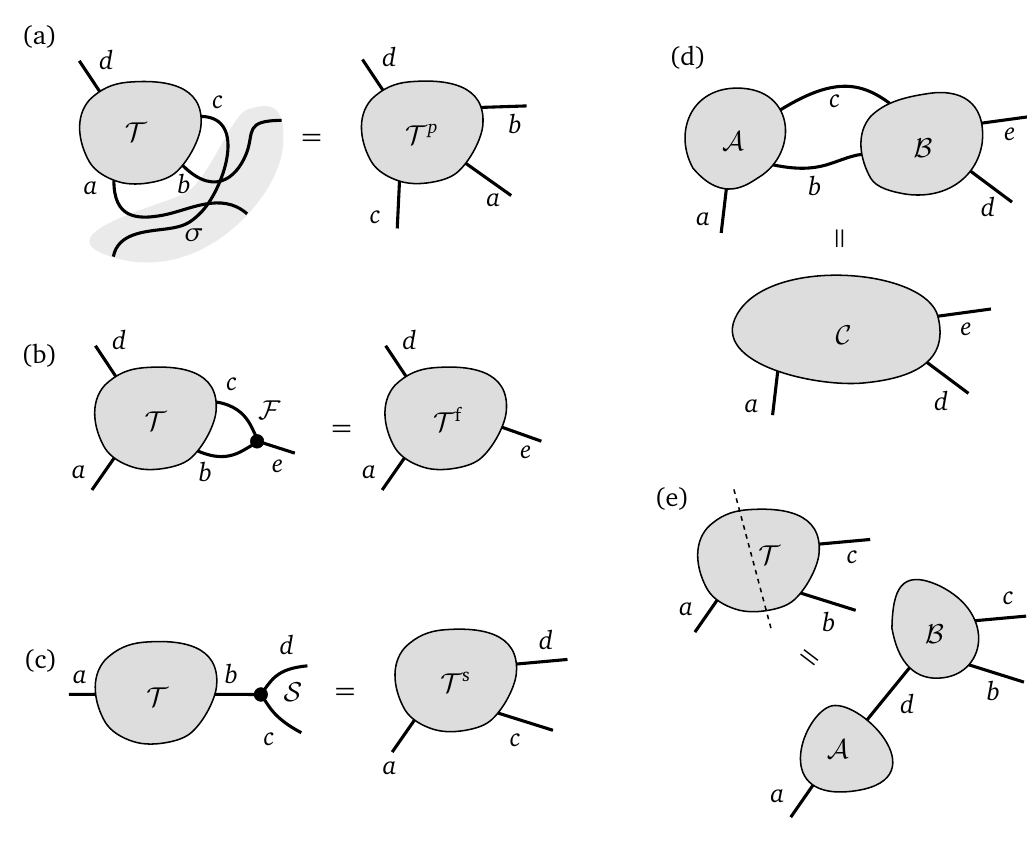
Figure 6: Basic tensor operations. Common TN operations can be separated into elemental steps including: (a) Link permutation. Graphically, the permutation of links of a tensor T is shown by intertwining the links ( σ , shaded area) to obtain the new order in T p . (b) Link fusion: Two or more links of a tensor T are joined to form a single one in the new tensor T f . This can be seen as a contraction with a fuse-node F (see Sec. 2.2.2). (c) Link splitting: a single link of a tensor T is split into two or more resulting in a tensor T s . The splitting is equivalent to the contraction with a split-node S . (d) Tensor contractions and (e) tensor